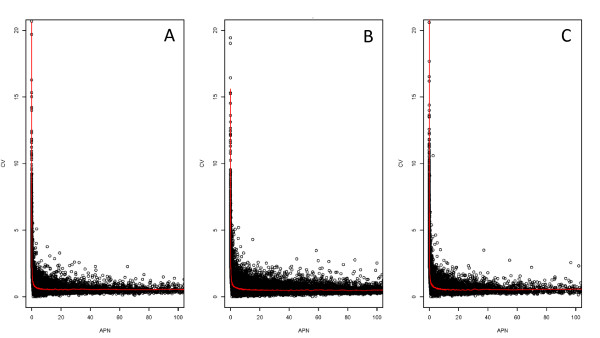
Coefficient of variation (CV) plotted on Y axis and average depth per nucleotide (APN) on X axis. Points with average depth of greater than 1000 are not displayed. Panel A is D. simulans BR2 TR2. Panel B is D. melanogaster female heads BR2 TR1. Panel C is TR1 for cell line c 167. Note that despite the difference in the number of mappable reads, the pattern of CV against the mean remains the same. CVs are very large when the average expression is low. Individual points represent exonic regions (Flybase 5.4) cubic smoothing line fit using R's smooth.spline function.